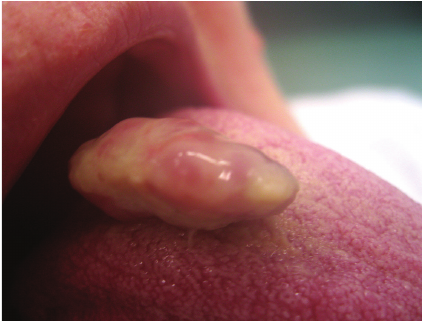
Figure 1: Paramedian dorsum of the tongue choristoma. Figure 2: Histological examination shows mature lamella lined by mucous membrane of the